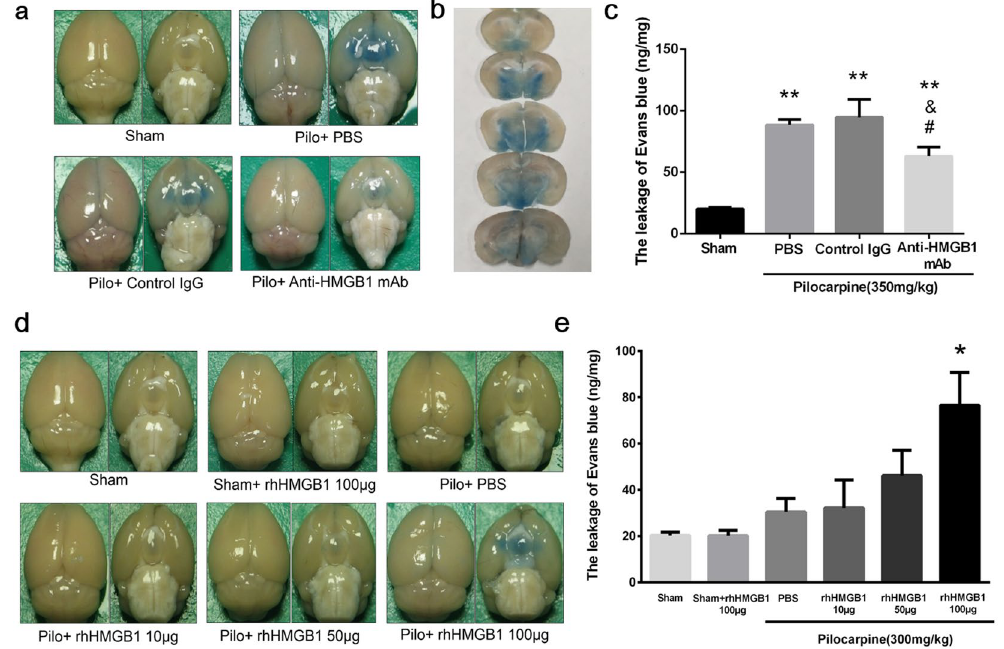
Figure 1. Effect of anti-HMGB1 mAb on BBB permeability in pilocarpine-induced acute status epilepticus. The permeability of brain capillary vessels was examined by intravenously injecting Evans blue (100 mg/kg, i.v.). Anti-HMGB1 mAb (1 mg/kg), control IgG, PBS was administered intravenously to mice which reached Racine stage 5 after onset of epilepsy ( a ). The distribution of Evans blue in brain were significantly shown in thalamus and hypothalamus region ( b ). The leakage of Evans blue into the brain parenchyma was quantified at 4 h after anti-HMGB1, control IgG or PBS injection, and the results are expressed as the means ± SEM of 5 mice. ** p < 0.01, & p < 0.05 and # p < 0.05 vs. Sham, PBS and Control IgG, respectively ( c ). The effects of intravenous administration of different concentrations of exogenous rhHMGB1 on BBB permeability after pilocarpine treatment are shown ( d ). The results were expressed as the means ± SEM of 7 mice. * p < 0.05 compared with Pilo + HMGB1 100 μ g ( e